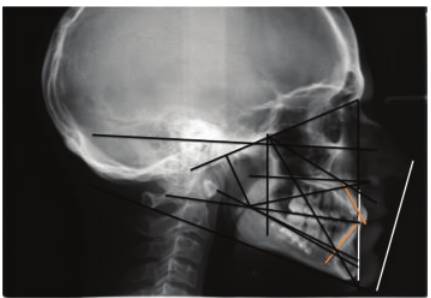
Figure 15: Laterolateral teleradiography of the skull and cephalometric analysis at the 6-year follow-up evaluation.